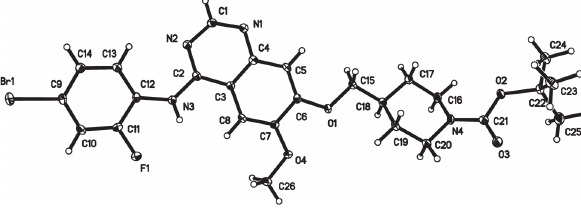
Table 1: Data collection and handling.